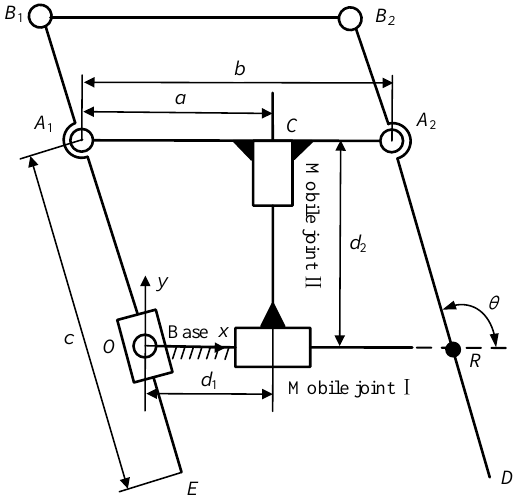
Figure 3. Dimensioning for kinematic analysis.